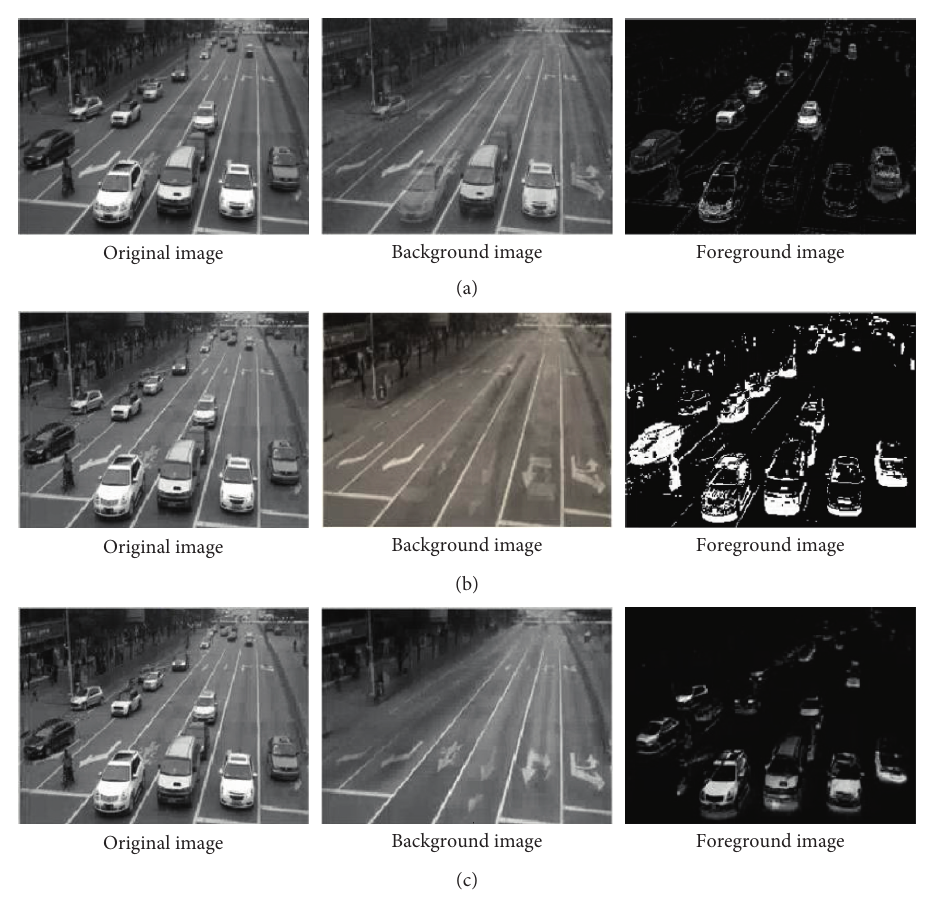
Figure 8: Detection results in complex intersection scenarios (a small number of queued